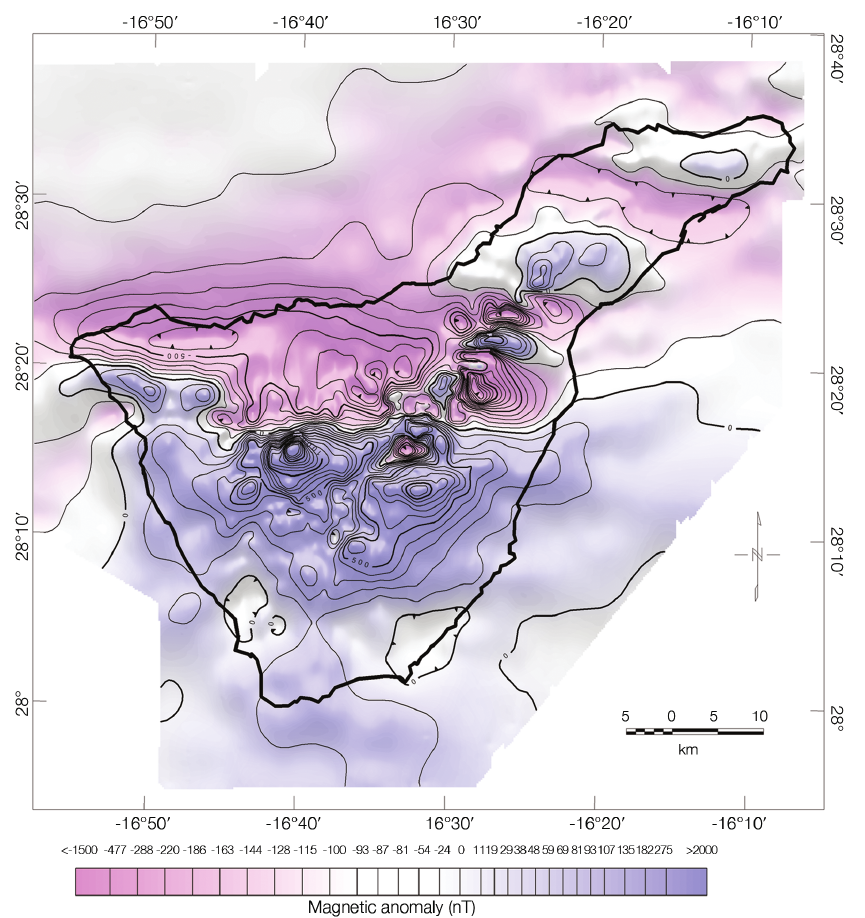
Fig. 6. Contoured magnetic anomaly map (total intensity) of Tenerife Island plotted in two colour density in- tervals to highlight anomaly frequency and wavelength. Latitude and longitude are north and west from Green- wich